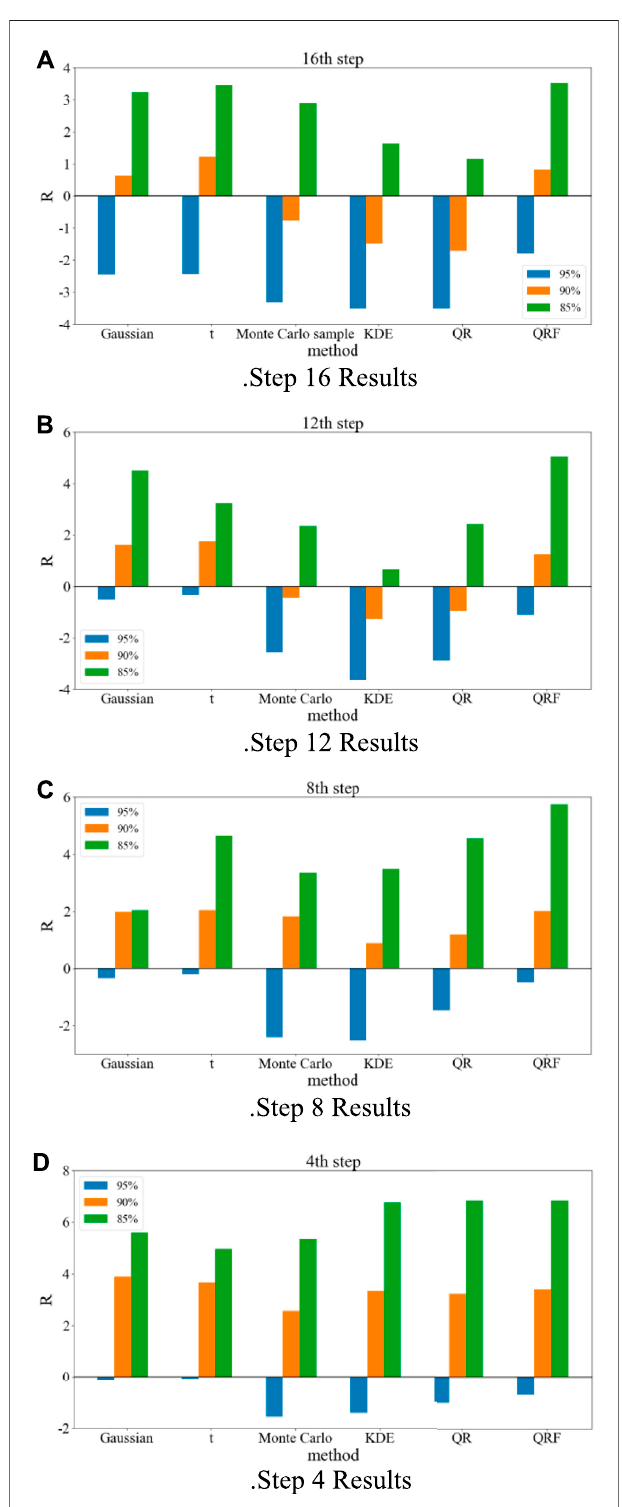
FIGURE 8 | Reliability analysis of different methods. The labels (A – D) is the interval prediction effect diagram of the method proposed in 16 th , 12 th , 8 th , 4 th .